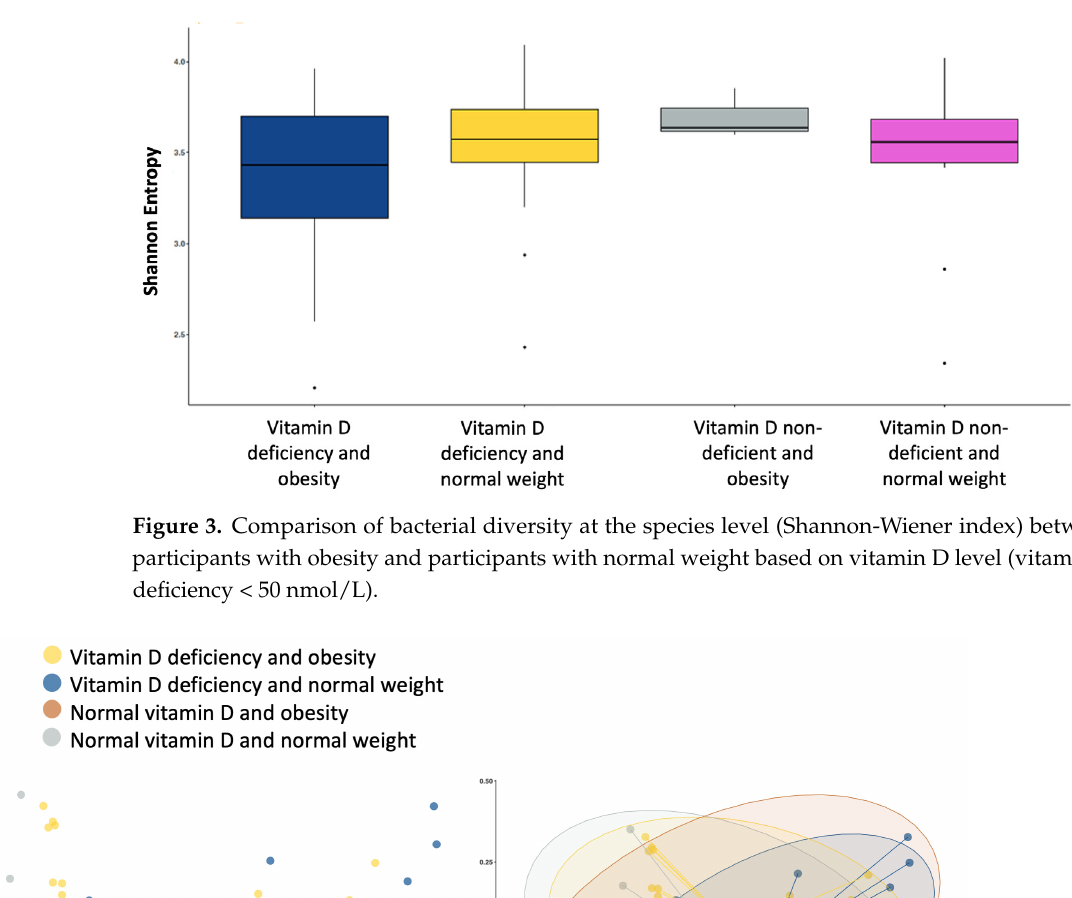
Figure 3. Comparison of bacterial diversity at the species level (Shannon-Wiener index) between participants with obesity and participants with normal weight based on vitamin D level (vitamin D deficiency < 50 nmol/L).